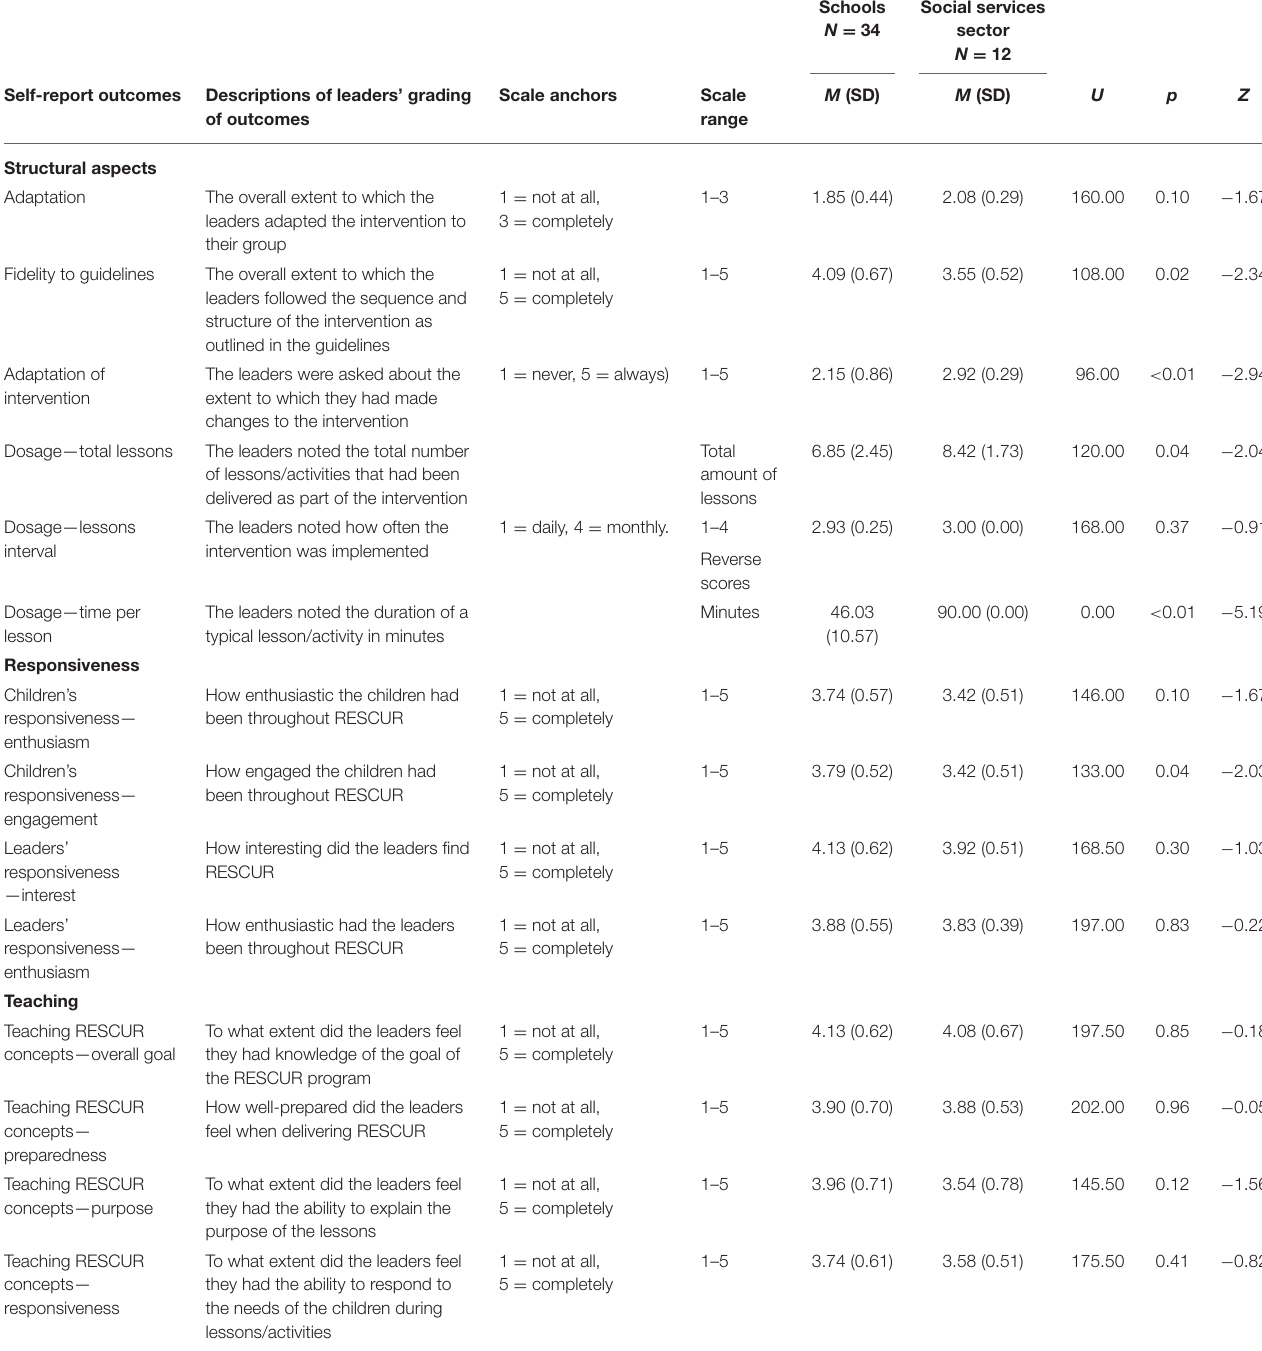
TABLE 3 | Leaders’ self-reports—implementation in schools and social services units after 3